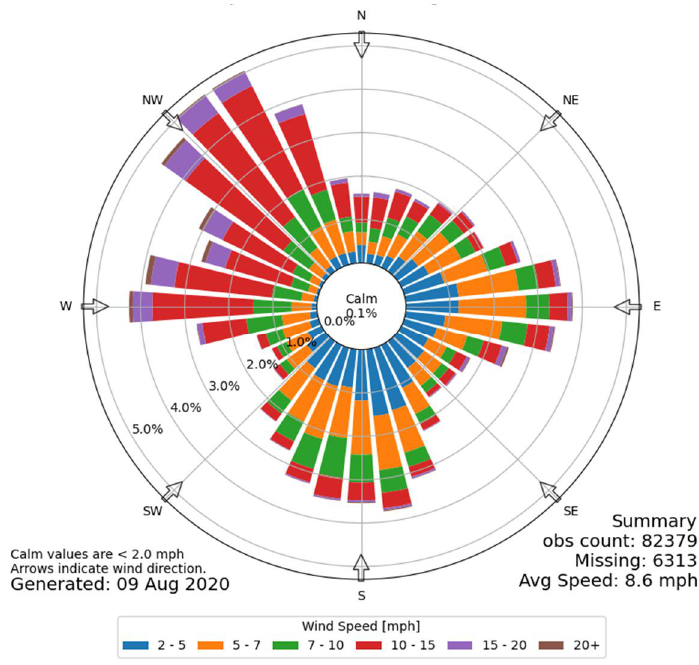
Figure 7. Wind speed and direction in Dubai, UAE